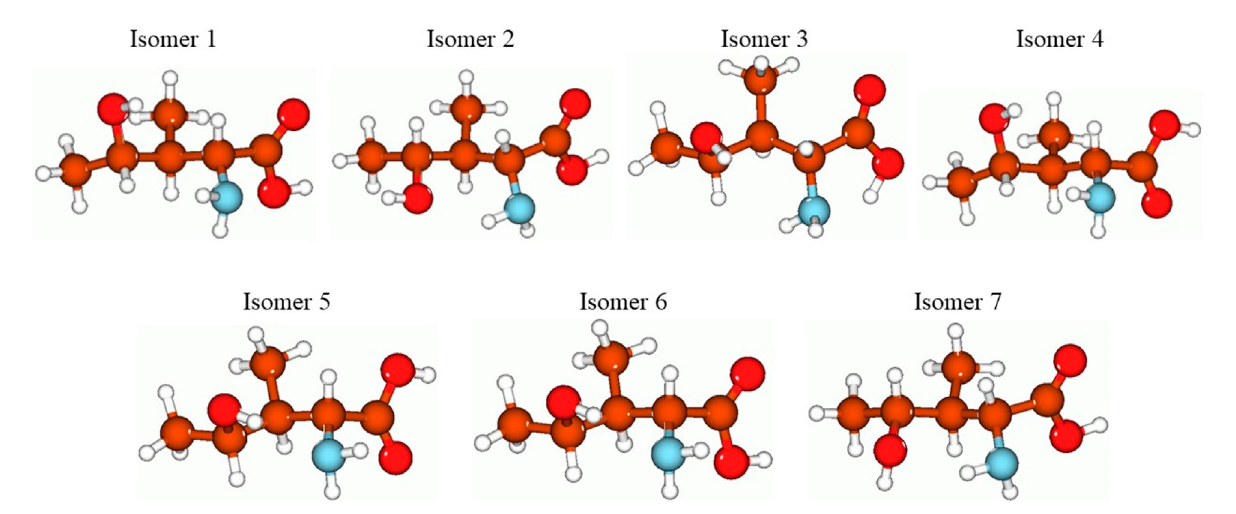
FIGURE 3 Structures oftheseven studied isomersofthe4-hydroxyisoleucineoptimized using theB3LYP/Def2TZVP method with theimpliciteffects ofwater. Color coding: brown for C, red for O, light blue for N, and light gray for H.